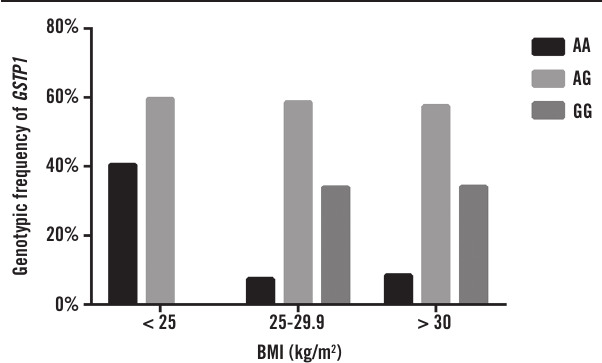
FigurE 2 − Genotype distribution of GSTP1 polymorphism in relation to BMI. Chi-square test p = 0.0001 GSTP1 : glutathione S-transferase P1; BMI: body mass index.